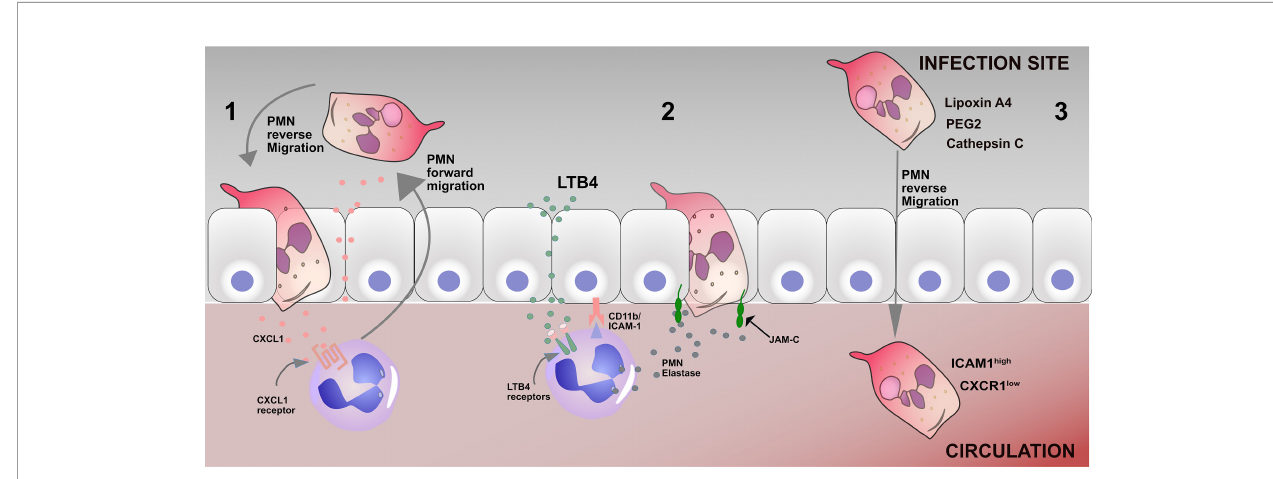
FIGURE 1 | Mechanisms of reverse migration in neutrophils 1. Leakage of CXCL1 into the endothelium as a result of a breached endothelium, therefore driving neutrophils to reenter the circulation; 2 Leukotriene B4 induces neutrophil elastase release (NE), which in turn cleaves endothelial JAM-C and subsequently results in the disruption of the endothelial junction and promotes neutrophil reverse migration. 3 Many factors, including Lipoxin A4, PEG2, and cathepsin C, can promote neutrophil reverse migration. The phenotype of reverse migrated neutrophils are ICAM1 high CXCR1 low .